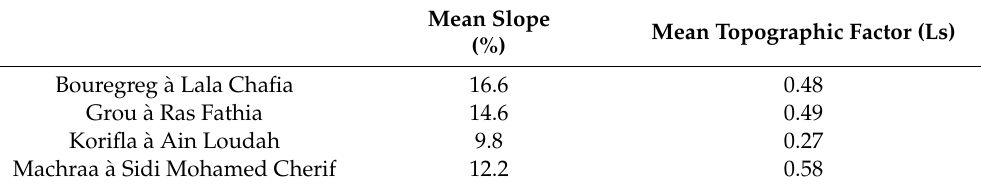
Table 9. Mean slope and mean topographic factor (LS).